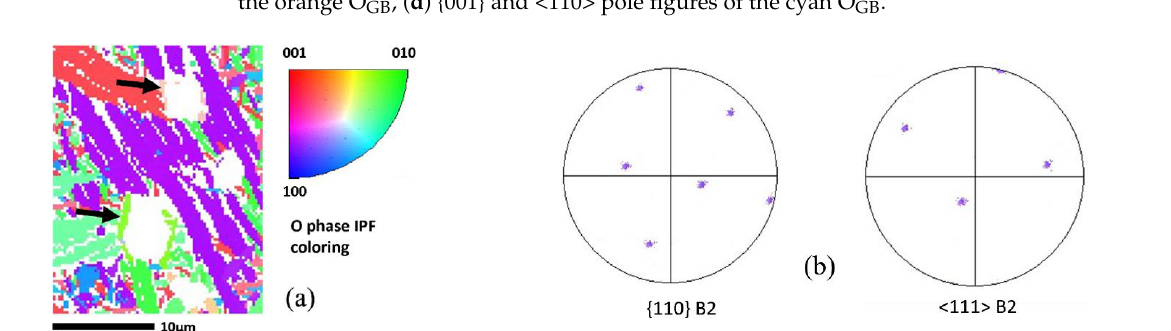
Figure 8. ( a ) partial view IPF map; {110} and <111> pole figures of the #1 B2 phase corresponding to ( b ) {001} and <110> pole figures of the purple lamellar O phase, ( c ) {001} and <110> pole figures of the orange O GB , ( d ) {001} and <110> pole figures of the cyan O GB .